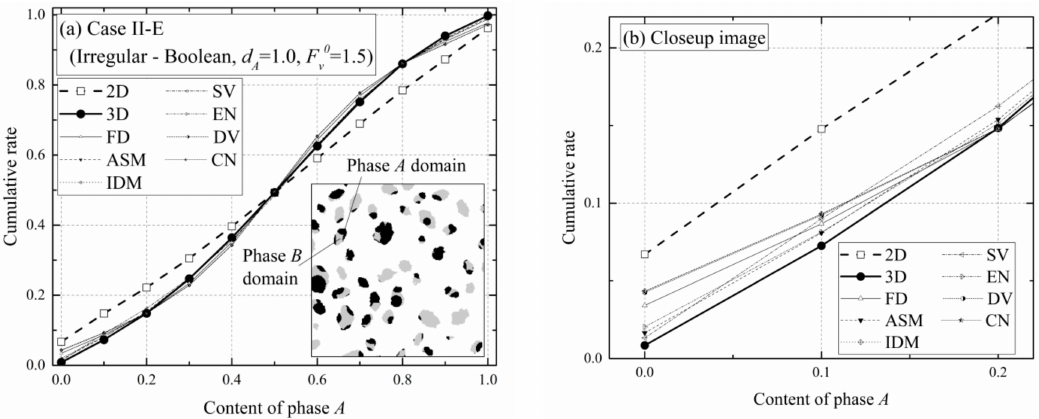
Figure 9. ( a ) Comparison of the 2D composition distribution, true 3D composition distribution, and seven types of 3D composition distribution estimated using seven types of texture analysis indices (FD, ASM, IDM, SV, EN, DV, and CN), for Case II-E (irregularly-shaped particles with Boolean internal structure, with d A = 1.0, F 0 v = 1.5), along with the corresponding partial sectional image; ( b ) Partial close-up of the chart in ( a ). FD—fractal dimension; ASM—angular second moment; IDM—inverse